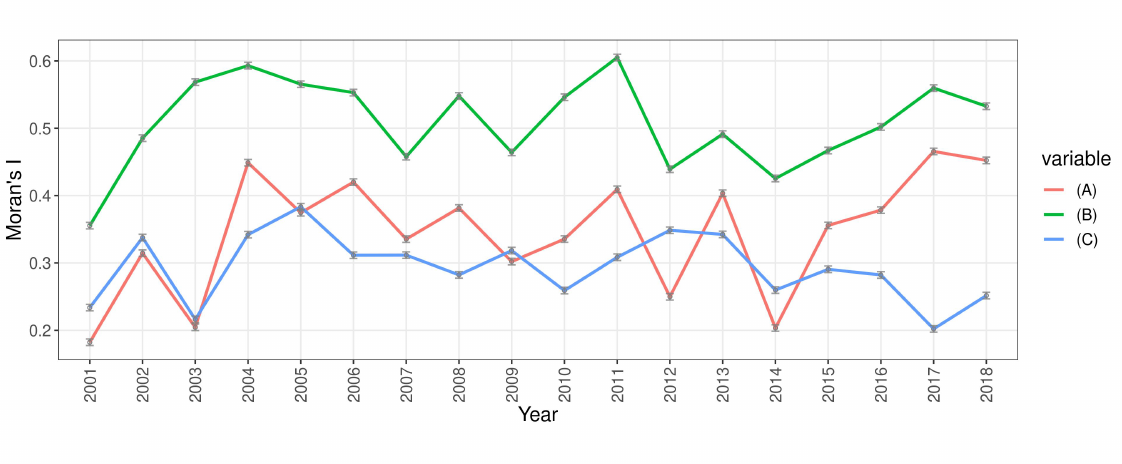
Figure 8 – Moran’s I (used to assess spatial autocorrelation) evolution from 2001 to 2018 for the transformed versions of yearly averages per 100 km 2 of: (A) Forest loss area of large clearings (>1 ha in size); (B) Number of small clearings (<1 ha in size); (C) Number of fire points located inside or around forest loss patches recorded by the MODIS